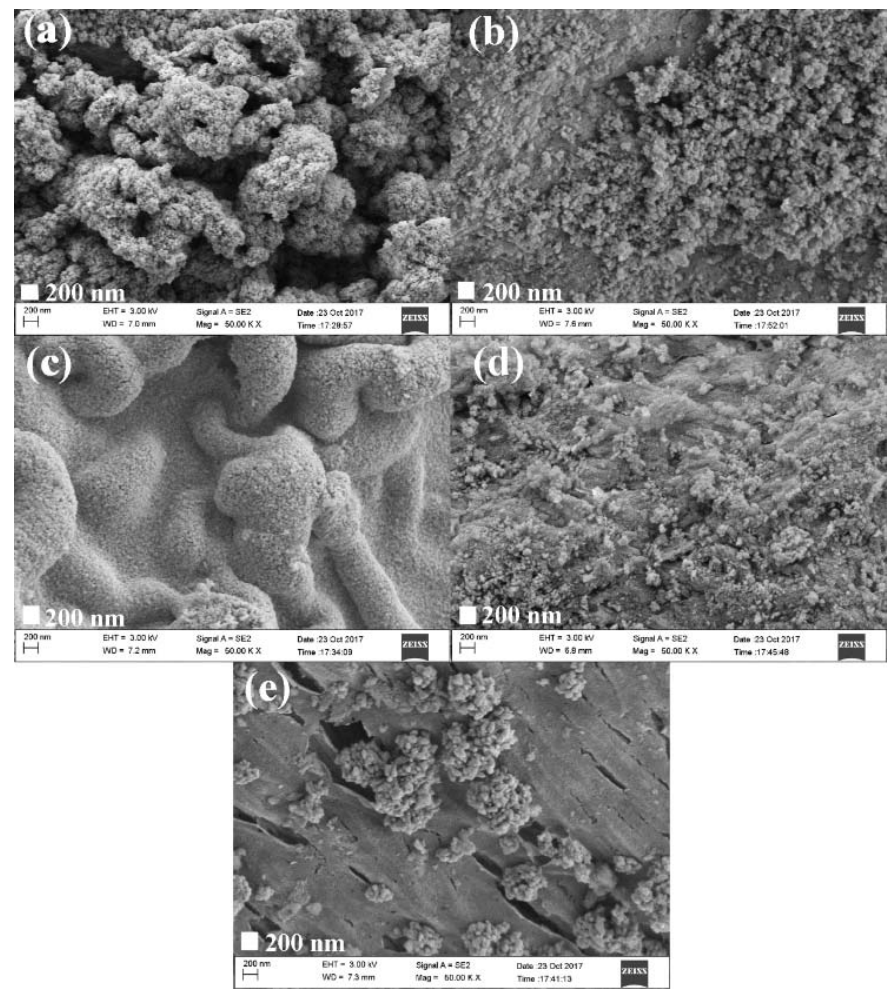
Figure 2. SEM images of ZnO/BC samples: ( a ) sample a, ( b ) sample b, ( c ) sample c, ( d ) sample d, and ( e ) sample e.